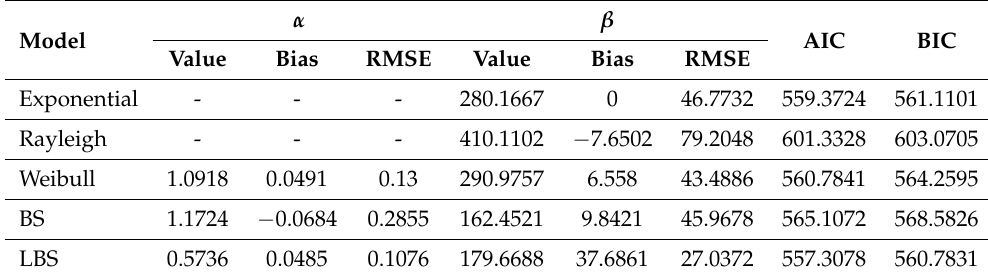
Table 3. Values of MLEs, AIC and BIC of Exponential, Rayleigh, Weibull, BS, LBS and Laplace BS distributions for Head and Neck Cancer